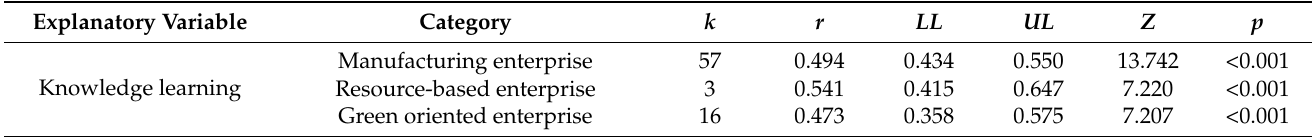
Table 6. Analysis Results of the Regulatory Effect of Research